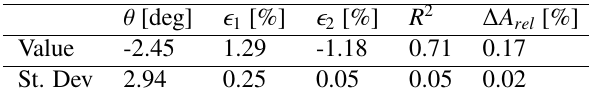
Table 1. Extracted Strain Parameters and Standard